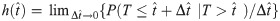
Constant and variable hazard functions.(A) Two different gamma densities of the time T at which the critic receives notification of an impending lever press. (B) Corresponding hazard functions h(t^)=limΔt^→0{P(T≤t^+Δt^|T>t^)/Δt^}. Note that the hazard function is constant in the G(1,1) case, but increases with time in the G(2,1) case.